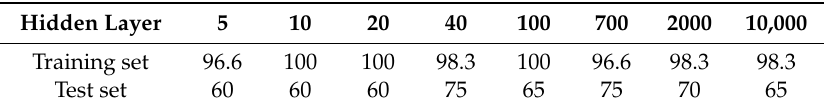
Table 9. Accuracy with different hidden layer